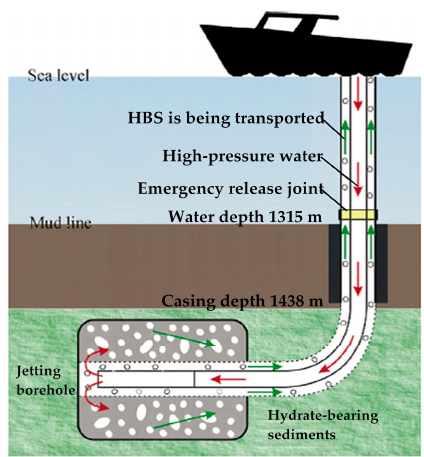
Figure 2. Schematic diagram for the trial production of marine natural gas hydrates (NGHs) through fluidization (modified from Zhou [20]). HBS: hydrate-bearing sediment.